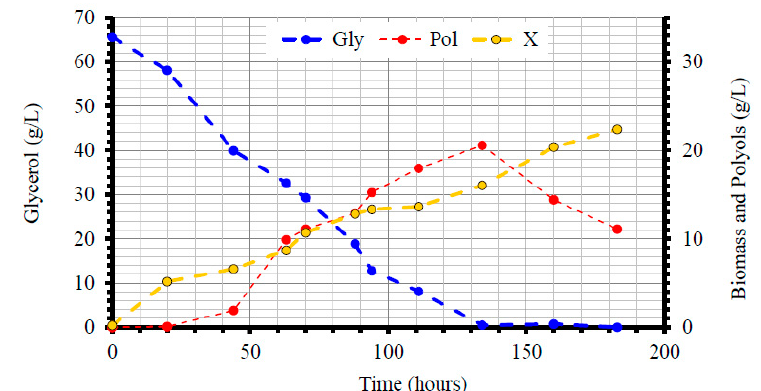
Figure 6. Kinetics of dry yeast cell mass production ( X , g/L), glycerol assimilation ( Gly , g/L) and total polyols production ( Pol , g/L) during Yarrowia lipolytica growth on initial glycerol adjusted to ≈ 70 g/L in shake-flask experiments under nitrogen-limited conditions. Culture conditions as in Table 3. Each experimental point is the mean value of two independent determinations (SE ≤ 18%).